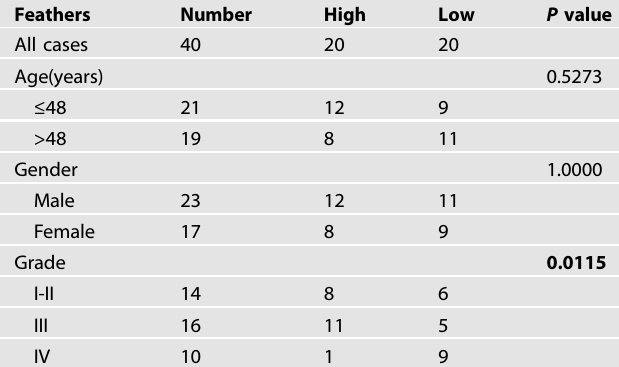
9 Total data of 40 glioma patients were analyzed. The expression of RBP-J in the macrophages from the glioma tissue samples was assayed by qRT-PCR, and the median expression level of RBP-J was used as the cutoff. Data were analyzed by Fisher ’ s exact test or Chi-square test. P -value in bold indicates statistically signi fi